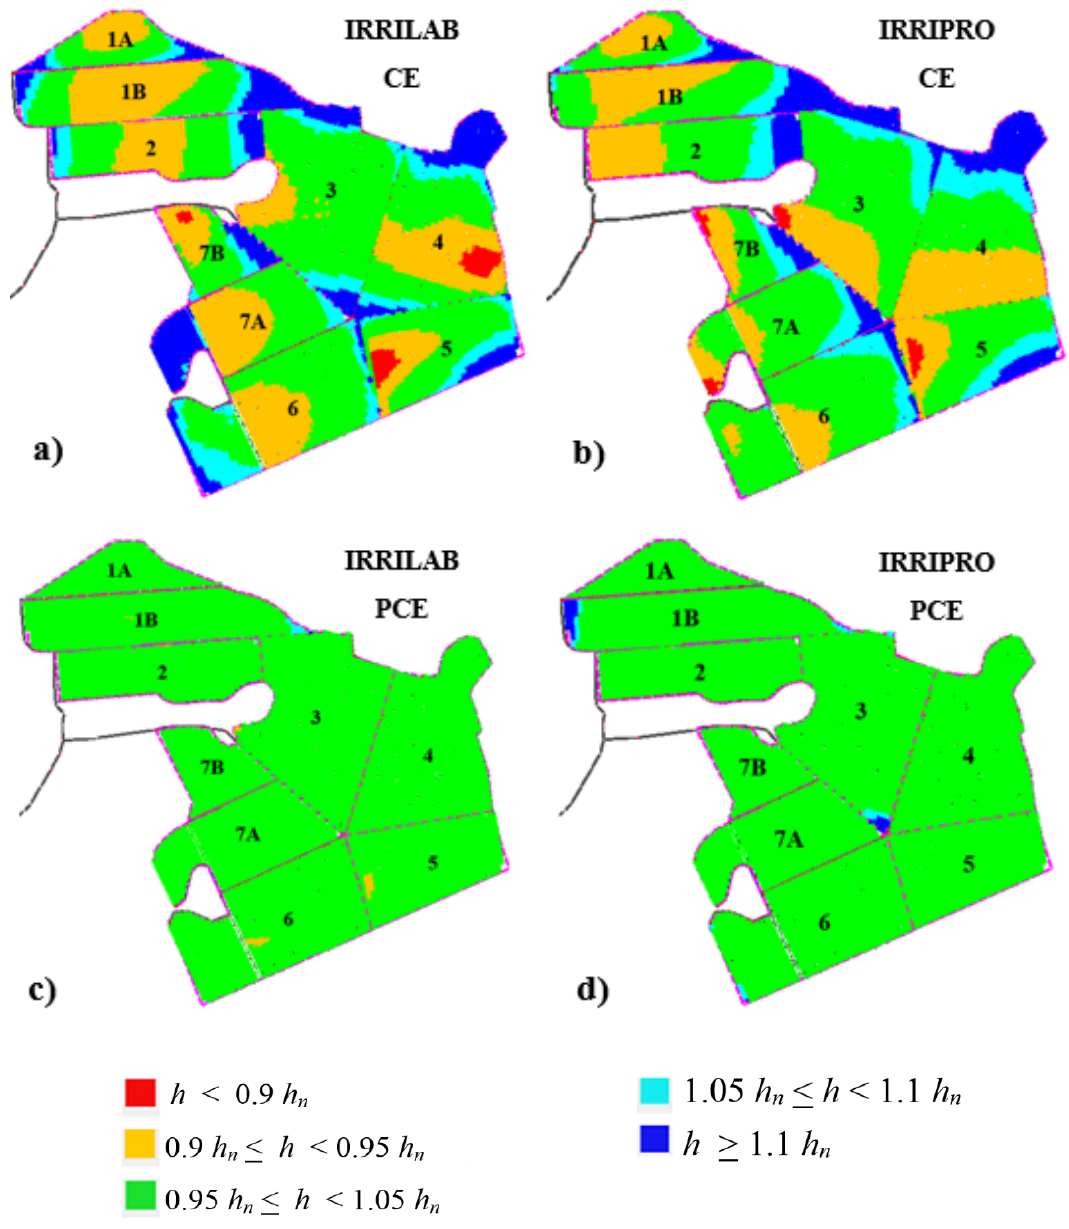
Figure 8. Emitters’ pressure head distribution maps, pertaining to the design parameters of IRRILAB ( a , c ) and IRRIPRO ( b , d ) software applications, for the farm subdivided into nine sectors, in case of using common emitters (CE) ( a , b ) and pressure compensating emitters (PCE) ( c , d ).